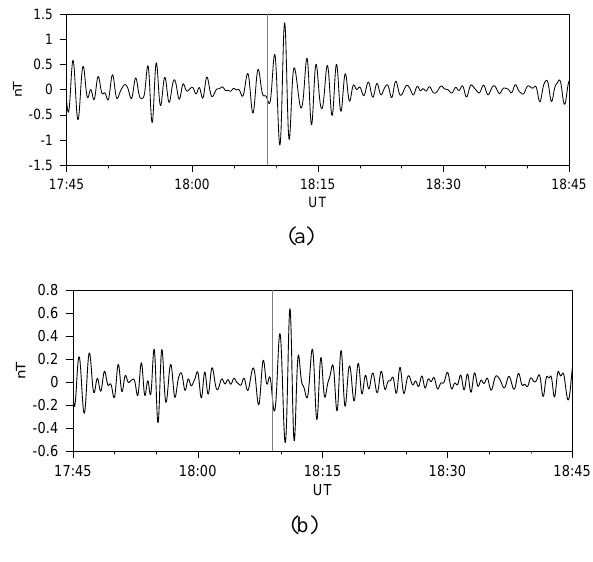
Fig. 2: Perturbations in the H component of the magnetic field at ground stations (a) Yinchuan [YCB] and (b) Kakioka [KAK]. The waveforms are bandpass filtered over the Pi2 frequency range. Fig. 1: Electron flux data for 21 January 2003 from SOPA Fig. 1. Electron flux data for 21 January 2003 from Synchronous instruments on LANL geosynchronous satellites. The Orbit Particle Analyzer (SOPA) instruments on LANL geosyn- four traces in each panel represent different energy chan- chronous satellites. The four traces in each panel represent different nels; from top to bottom they are 50–75, 75–105, 105– energy channels; from top to bottom they are 50–75, 75–105, 105– 150 and 150– 225 keV . In the upper right corner of each 150 and 150–225keV. In the upper right corner of each panel is an inset indicating the local time of the satellite at the event epoch (the panel is an inset indicating the local time of the satellite arrow points sunward). at the event epoch (the arrow points sunward).